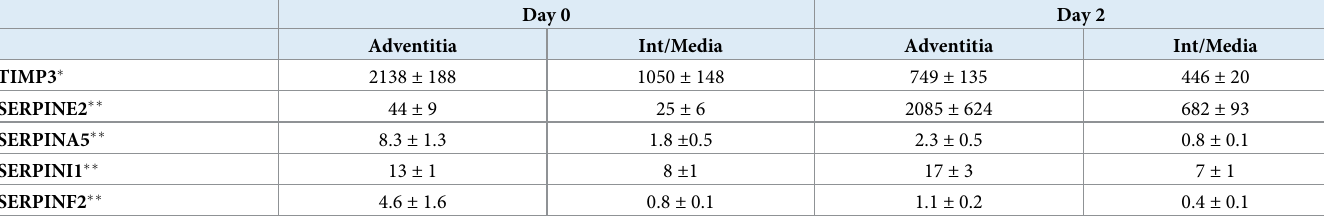
Table 3. Expression of inhibitors of versican-degrading proteases in cultured adventitial and intimal/medial tissue.